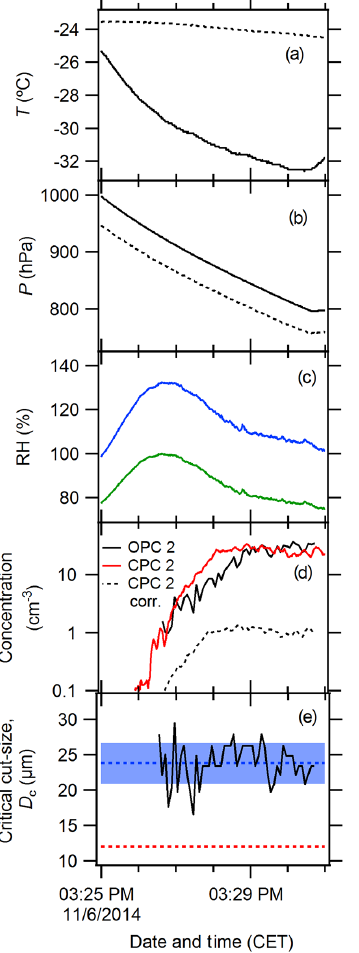
Figure 6. Temporal plots of the AIDA freezing experiment. Arrays of alphabetical panels represent the chamber gas T (solid line) and the IS-PCVI nozzle T (dotted line) (a) , P in the AIDA chamber (solid line) and the IS-PCVI (dotted line) (b) , RH with respect to water (green line) and ice (blue line) (c) , number concentration of >15µm D ve AIDA particles measured by the OPC 2 (black solid line), residuals measured by the CPC 2 (red solid line) and corrected residual concentration according to Eq. (6) (black dashed line) (d) , and optimized D c (black line) overlaid on the average D c (blue dot- ted line) ± standard deviation (blue shaded area) (e) . The red dotted line in panel (e) represents the cut size predicted by the CFD sim- ulation. RHs were determined with an accuracy of ± 5% using the mean gas temperature and the mean water vapor concentration (Hi- ranuma et al., 2014b and references therein).